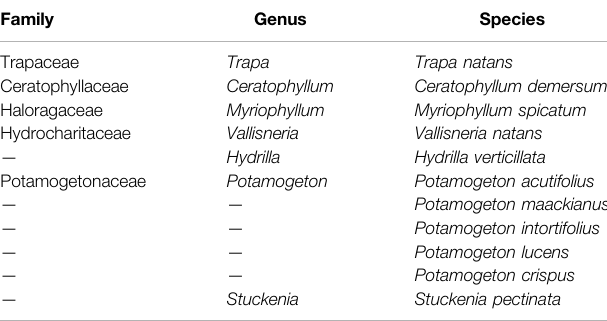
TABLE 1 | List of aquatic plant species in two zones before harvesting.